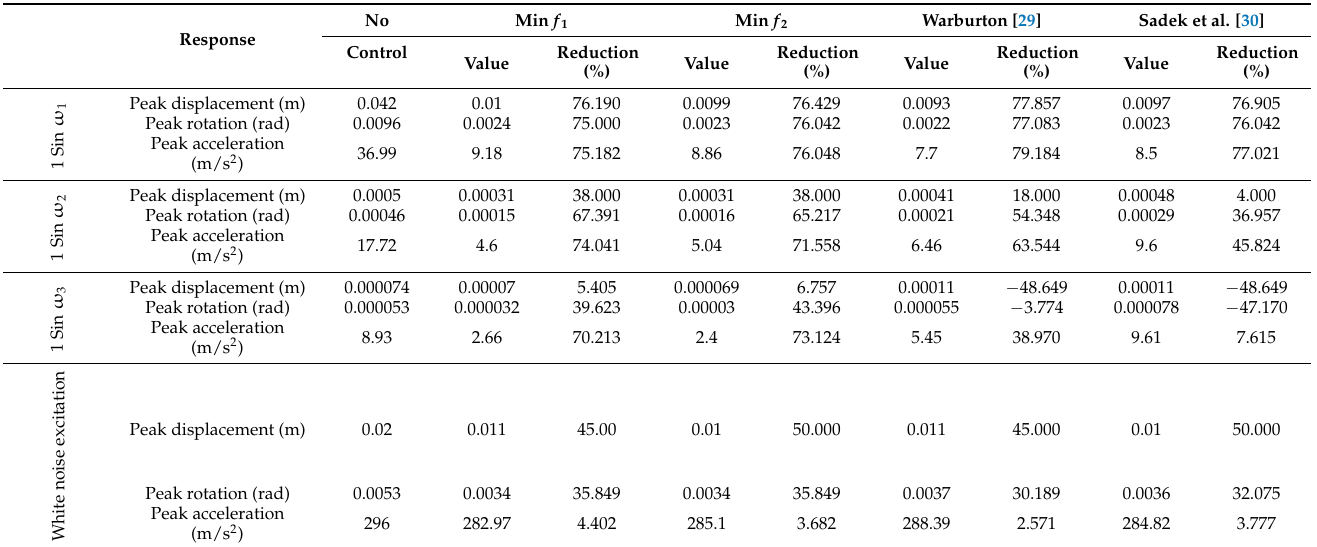
Table 2. In compression of 6th peak node responses of the cantilever beam for the first mode control considering peak displacements, rotations, and peak accelerations.